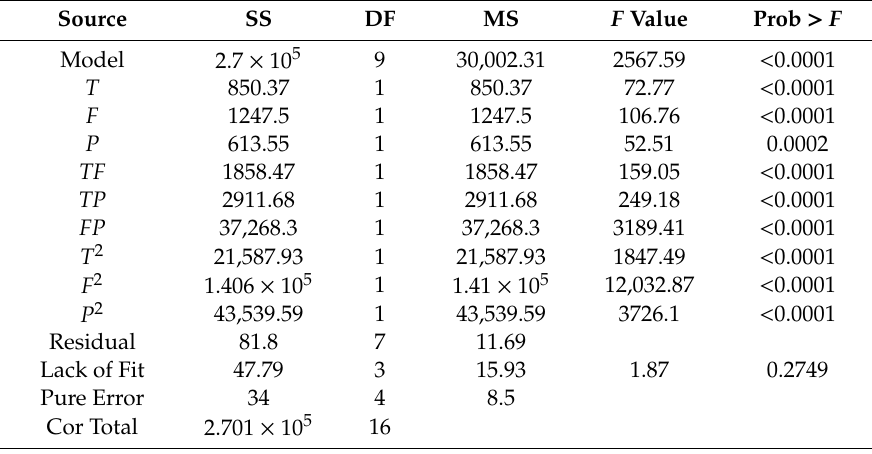
Table 3. ANOVA results for response surface quadratic model of tensile